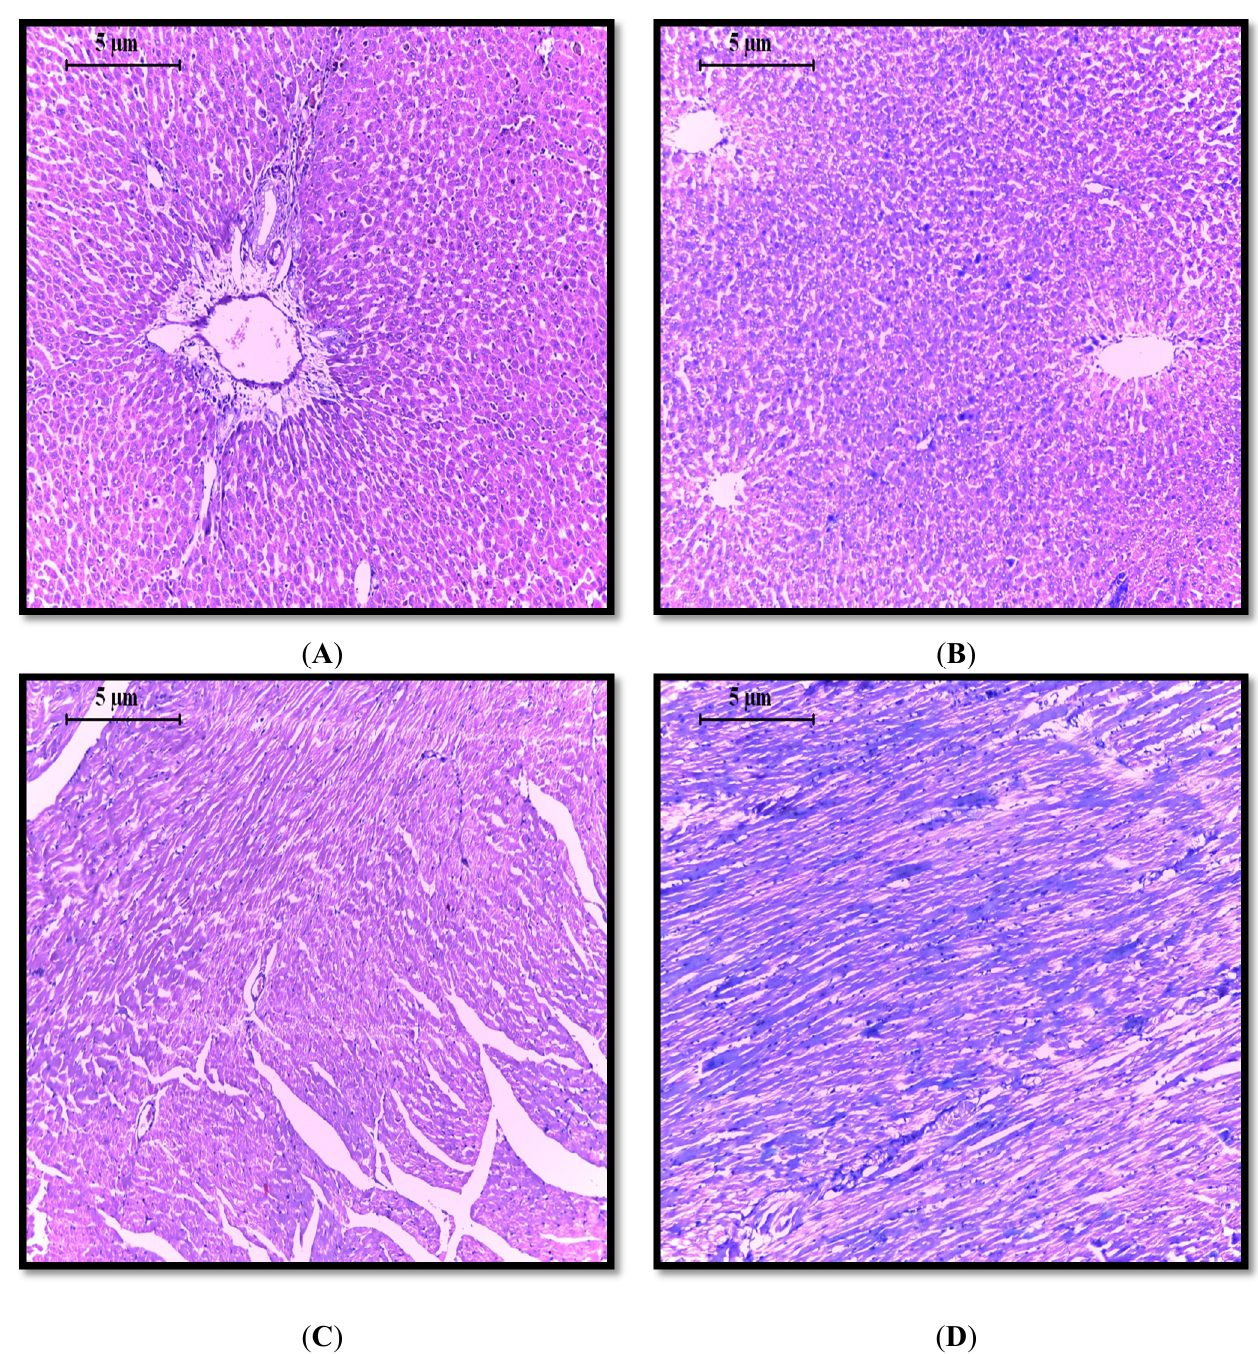
Figure 4. Histological appearance of tissue sections of various organs. ( A ) section of liver of test animal ( B ) section of liver of control animal; ( C ) section of heart of test animal; ( D ) section of heart of control